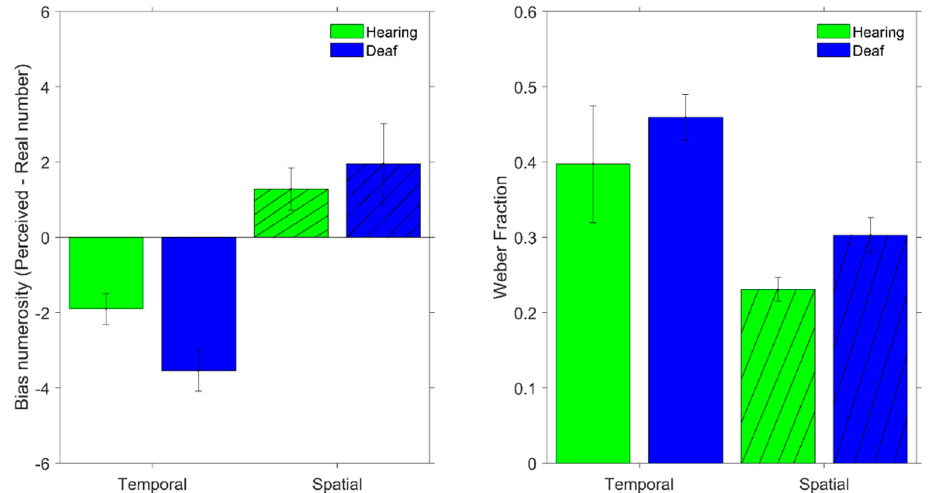
Figure 3. Results of the estimation task in terms of accuracy ( left ) and precision ( right ) for both groups of participants. Data for deaf participants are in blue, while those for the hearing control group are in green. Plain and hatched bars indicate the results for the estimation of the temporal and spatial numerosities, respectively. Error bars represent ±1 SEM.